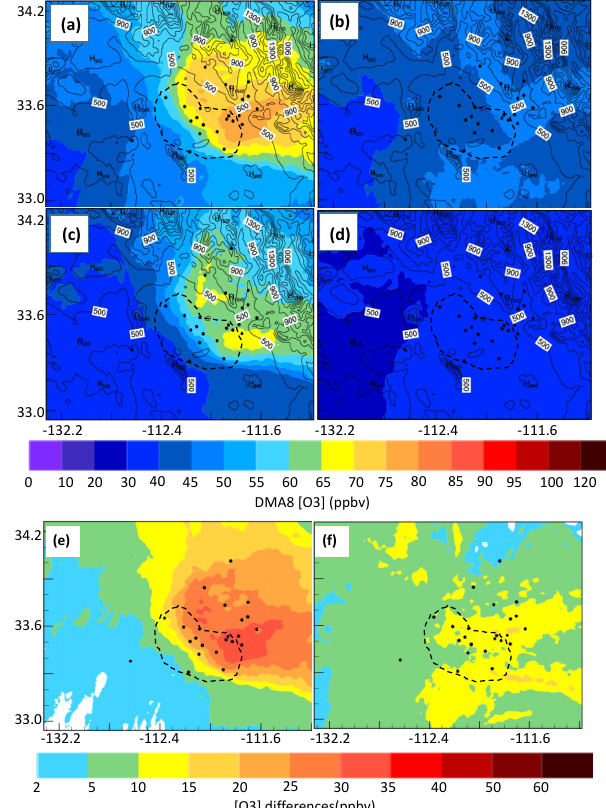
Figure 7. DMA8 [O 3 ] spatial distributions in Greater Phoenix and surrounding areas on 19 July 2005: (a) CTRL, (b) noAZ, (c) noCA, (d) BILB, (e) CTRL-noAZ, and (f) CTRL-noCA. Contours repre- sent terrain elevations. Dots show O 3 observation sites. Circle indi- cates the approximate location of Phoenix urban